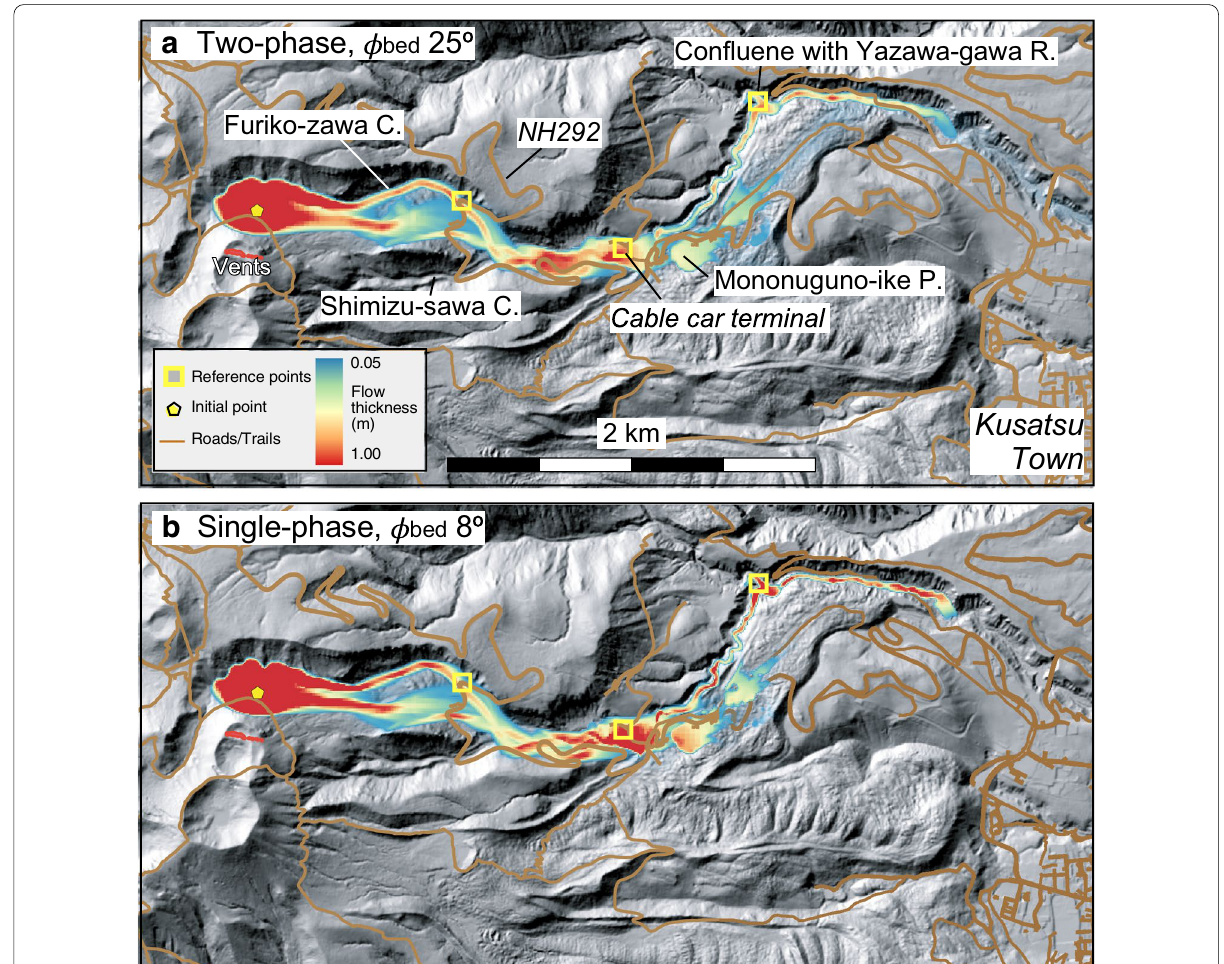
Fig. 12 Simulated flow distribution of the Scenario B (snow slurry), a two-phase with the bed friction angle of 25° and b single-phase with the bed friction angle of